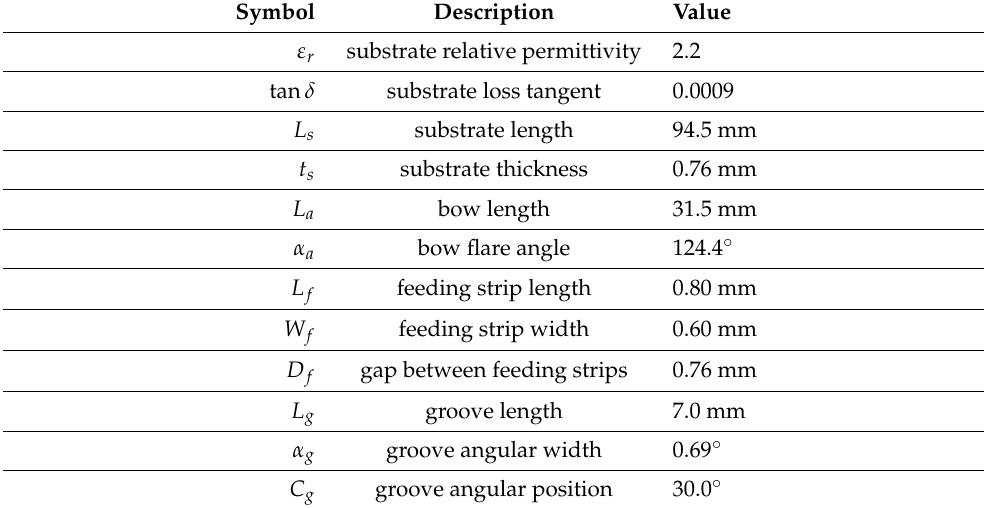
Table 2. Antenna parameters.